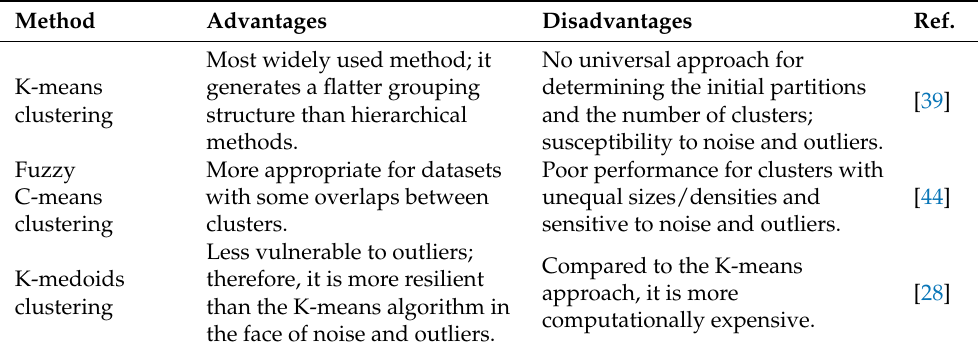
Table 2. Advantages and disadvantages of partitional clustering